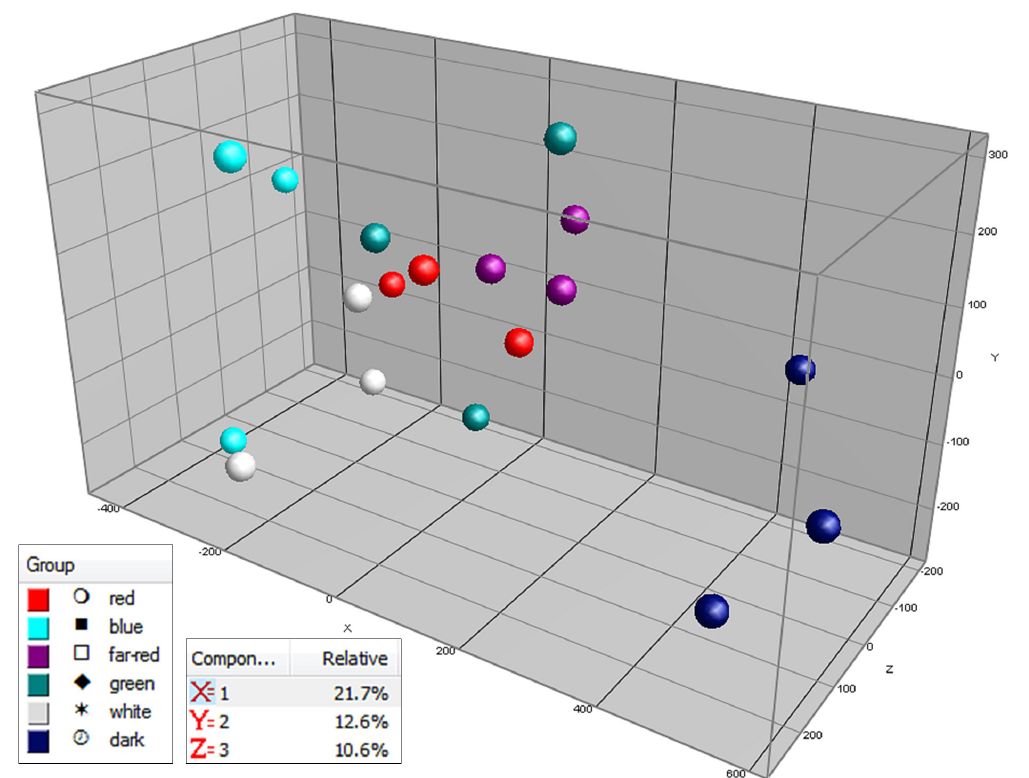
Figure 7. Principle component analysis (PCA) of tomatoes treated with different light qualities, based on 437 tomato pericarp metabolites detected by LC-MS based untargeted metabolomics. The fruits were treated with different light spectrum treatments (350 μmol m −2 s −1 ) and darkness for seven days (experiment 2). PC1 = X -axis = 21.7% explained variation; PC2 = Y -axis = 12.6% explained variation; PC3 = Z -axis = 10.6% explained variation. (Red treatment—red points, blue treatment—light blue points, far-red treatment—purple points, green treatment—dark green points, white treatment—white points, dark treatment—dark blue points.)